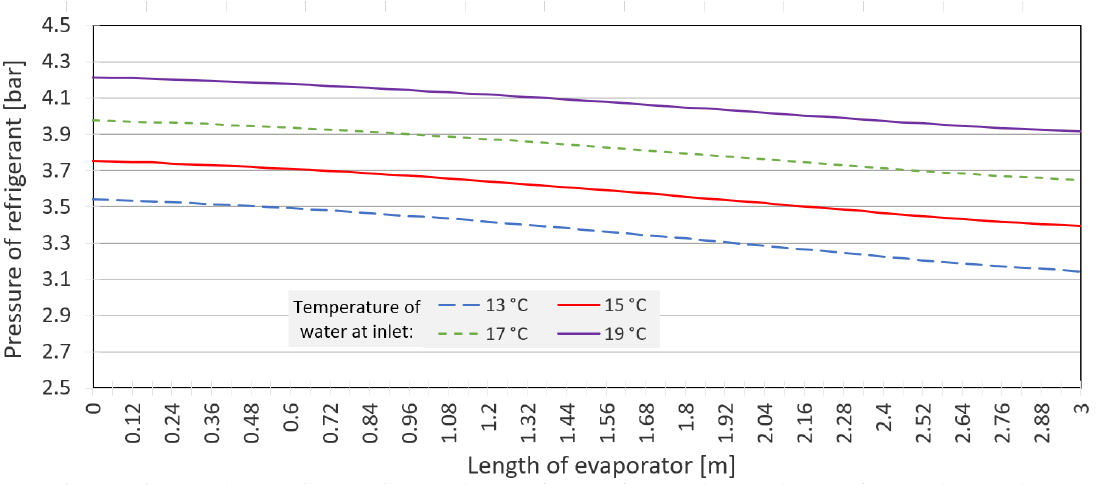
Figure 9. Variation of refrigerant pressure.